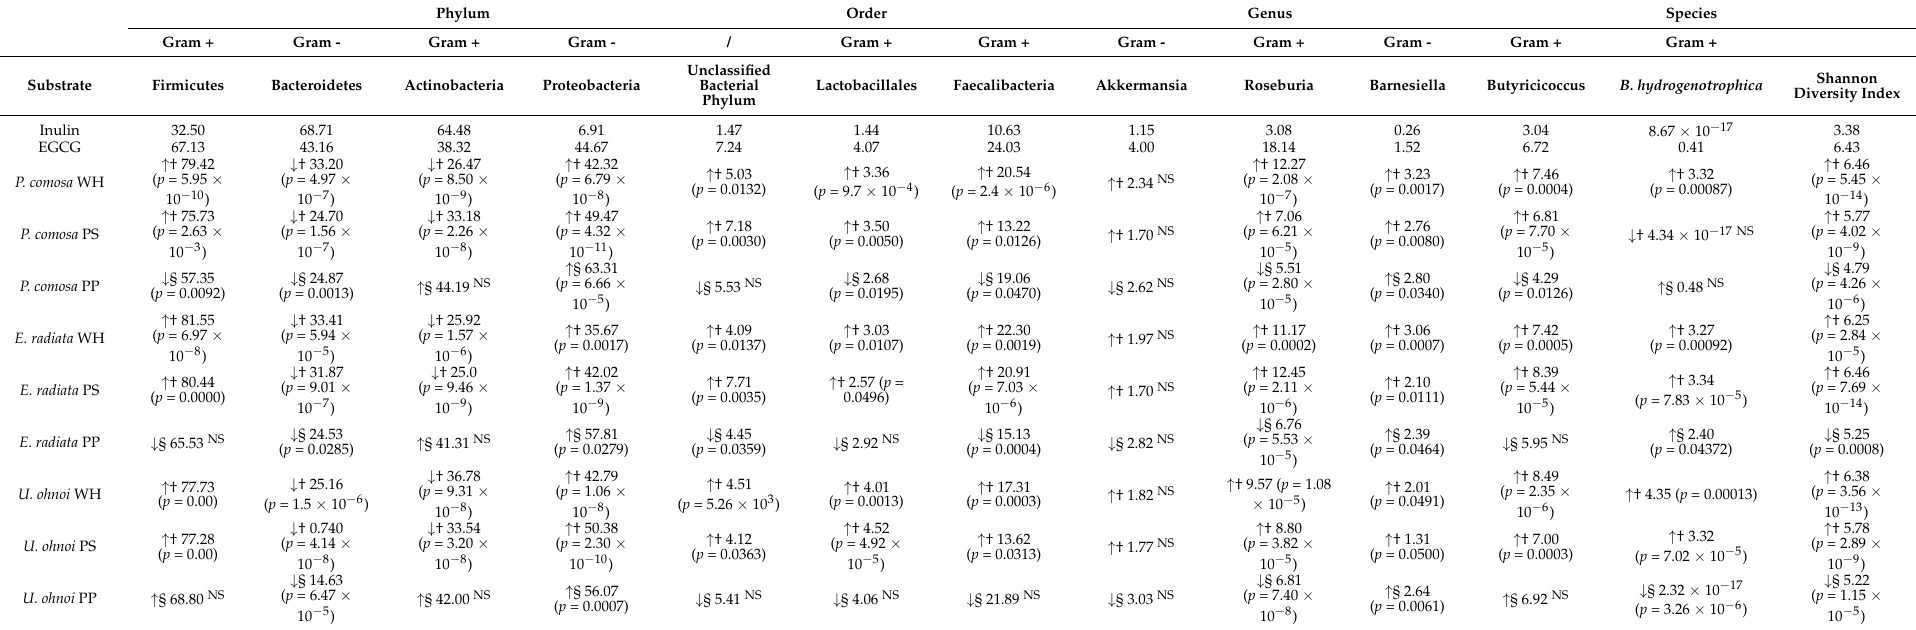
Table 8. Relative abundance (% of total abundance) of selected bacterial groups at 24 h that were significantly enhanced or decreased by WH, PS, or PP seaweed extracts compared to the INU or EGCG